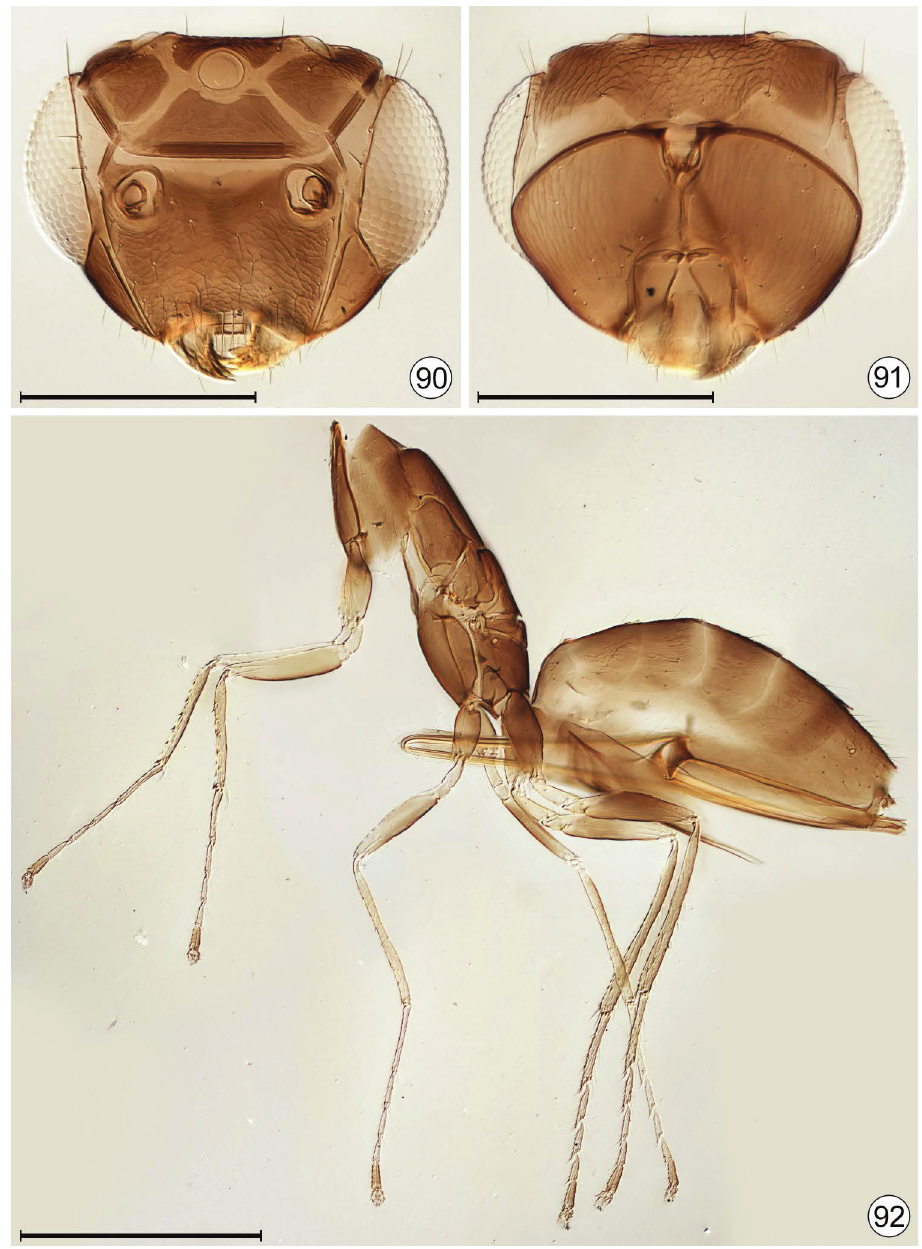
Figures 90–92. Neotriadomerus darlingi , paratype female (Boorabbin National Park). 90 head, anterior 91 head, posterior 92 mesosoma, legs and metasoma, lateral. Scale bar for 90, 91 = 200 μm; 92 = 500